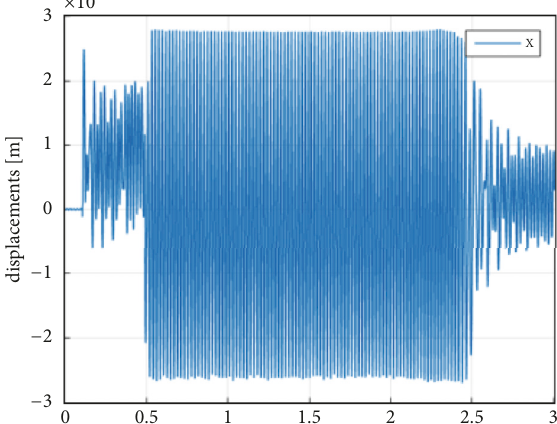
Figure 24: Predicted rotor horizontal displacements during a radial landing test (DE